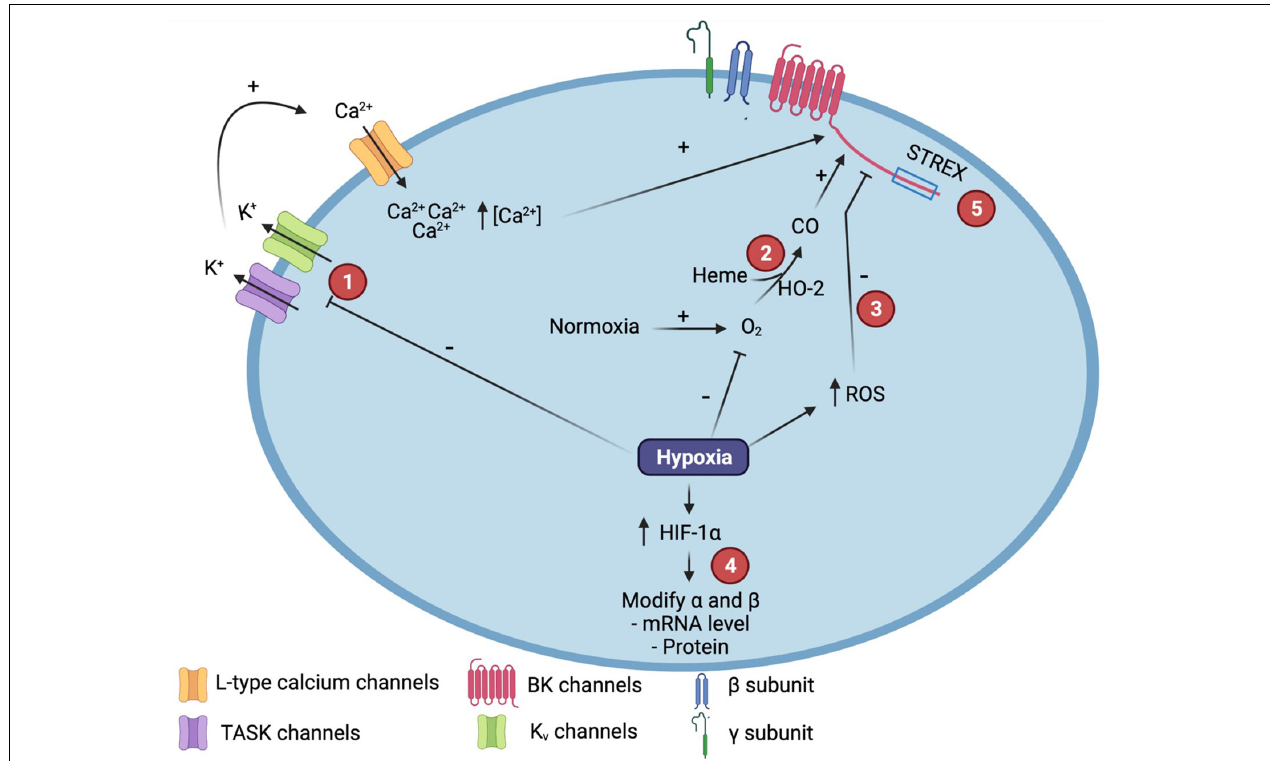
FIGURE 1 | Molecular mechanisms involved in the modulation of Calcium and voltage-activated potassium (BK) channel function by hypoxia. (1) Hypoxia promotes TWIK-related tandem pore domain acid-sensitive K + channel (TASK) or Kv channels inhibition that induces membrane depolarization, activation of L-type voltage-dependent calcium channels and the increase in intracelular calcium concentration, underpining BK channel activation. (2) In normoxia, hemeoxigenase (HO-2) catalyzes Heme degradation to produce carbon monoxide (CO), increasing the open probability (Po) of the BK channel. (3) ROS production increased after hypoxia induces the decreasing of BK channel Po. (4) After hypoxia, HIF-1 α is increased and modulates BK subunits expression through the interaction with hypoxia-response elements (HRE). (5) STREX variant confers to BK channel sensitivity to hypoxia. ROS, Reactive Oxygen Species; HIF, Hypoxia Inducible Factor. Created with